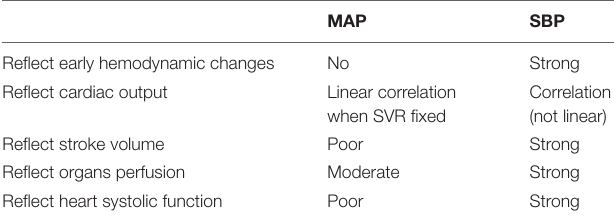
TABLE 1 | Differences of MAP and SBP in reflecting perfusion and